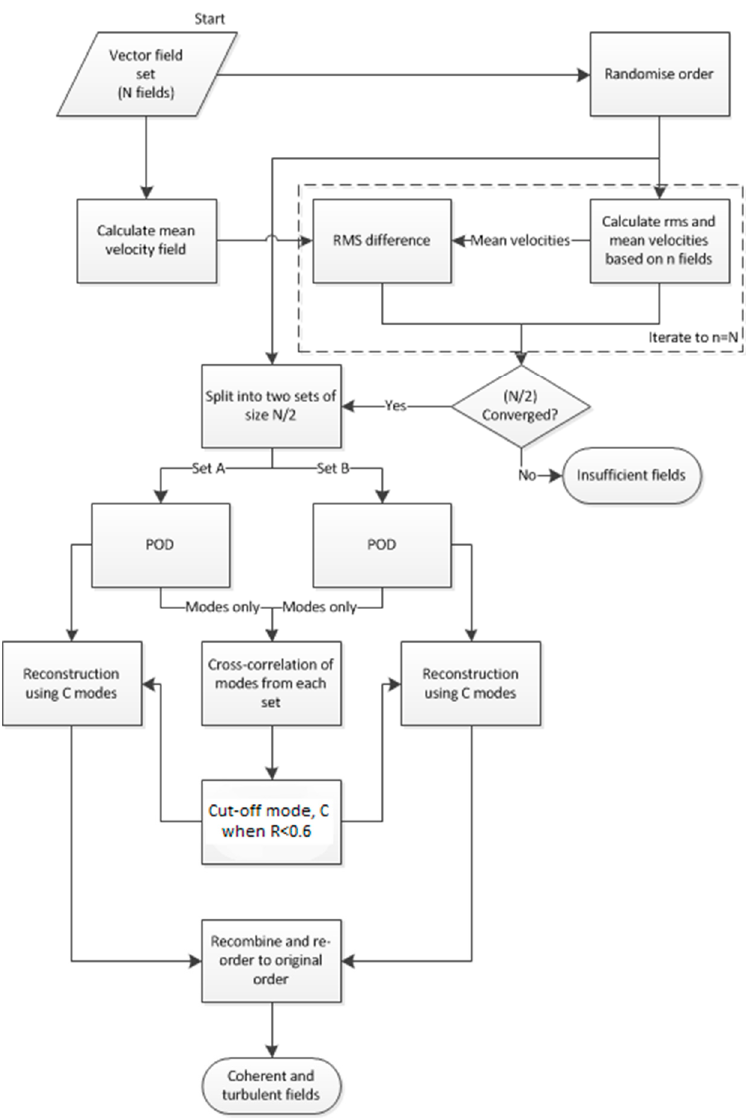
Figure 14. Diagrammatic overview of methodology.